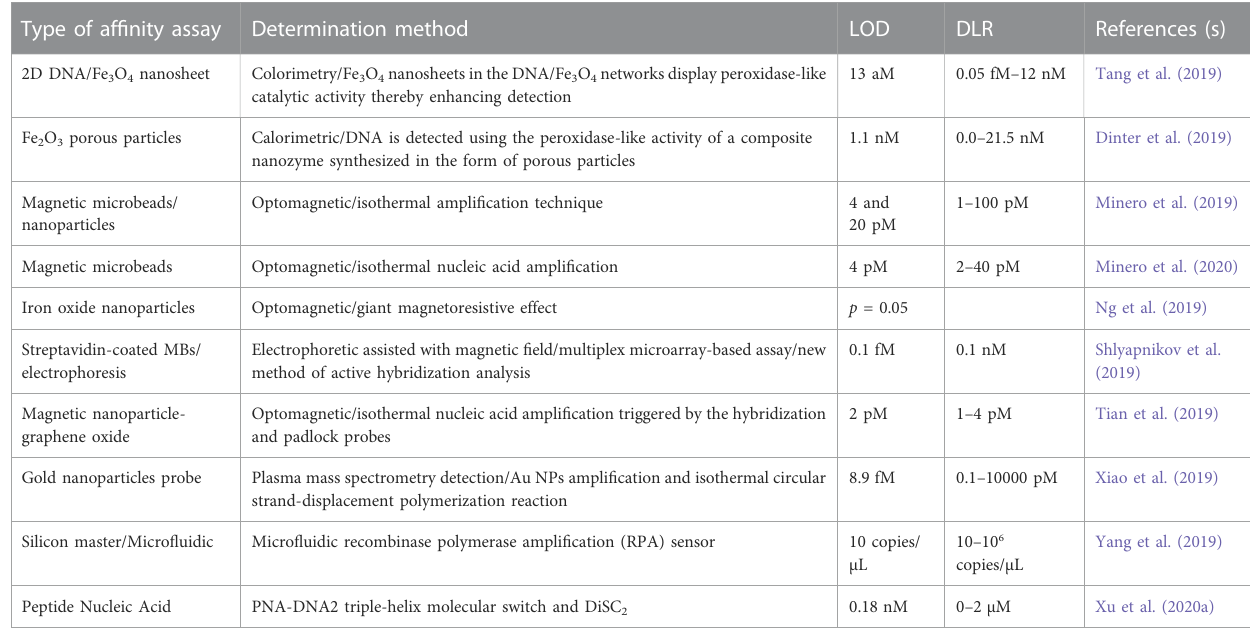
TABLE 3 Colorimetric-based DNA detection